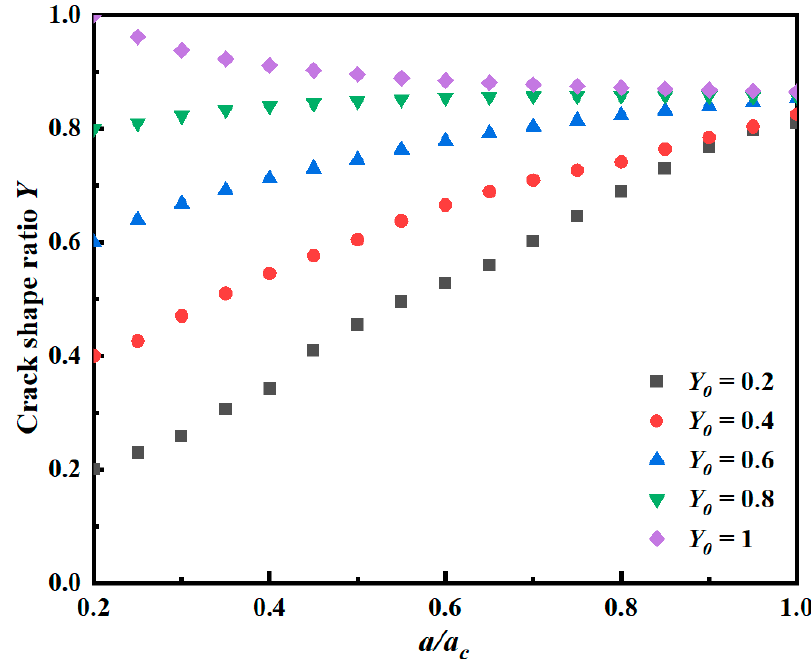
Figure 8. Variation of shape ratio during crack propagation.